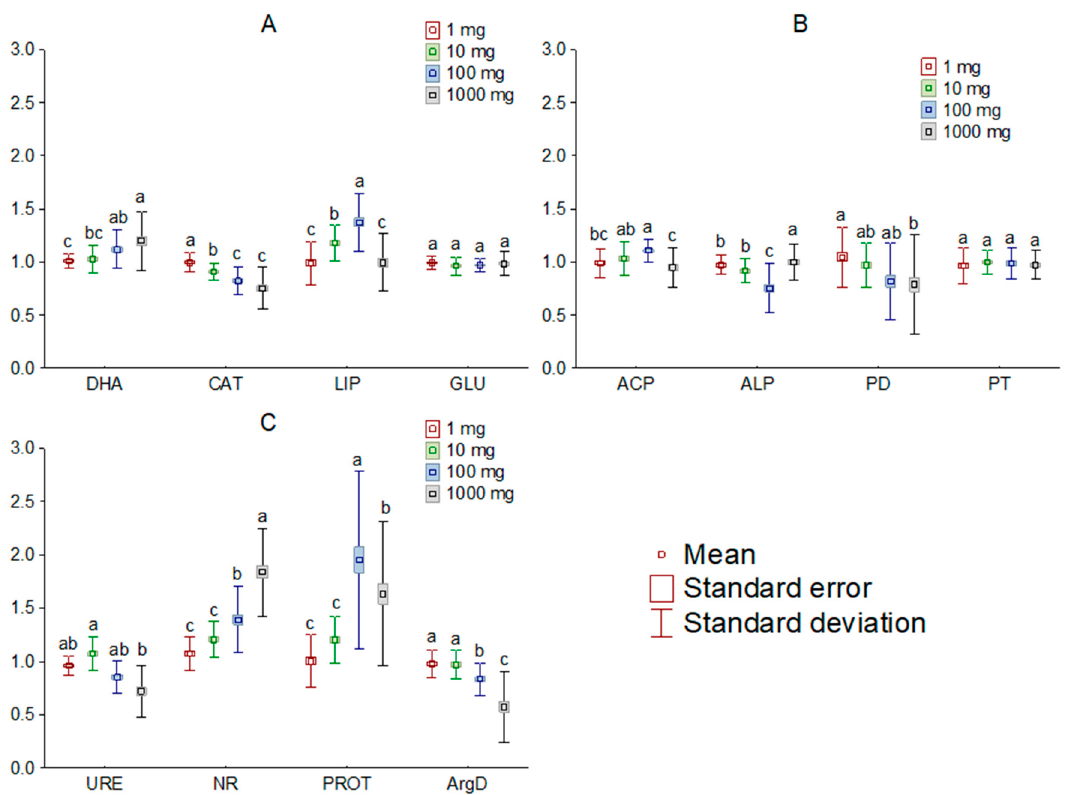
Figure 2. Mean relative activity of the enzymes involved in carbon ( A ), phosphorus ( B ), and nitrogen ( C ) cycle in the soil exposed to tetrabutylphosphonium bromide [TBP][Br] in pot experiment with spring barley, depending on the salt doses: values denoted by the same letters for each enzyme do not differ significantly on the level of p = 0.05 (Tukey HSD test),